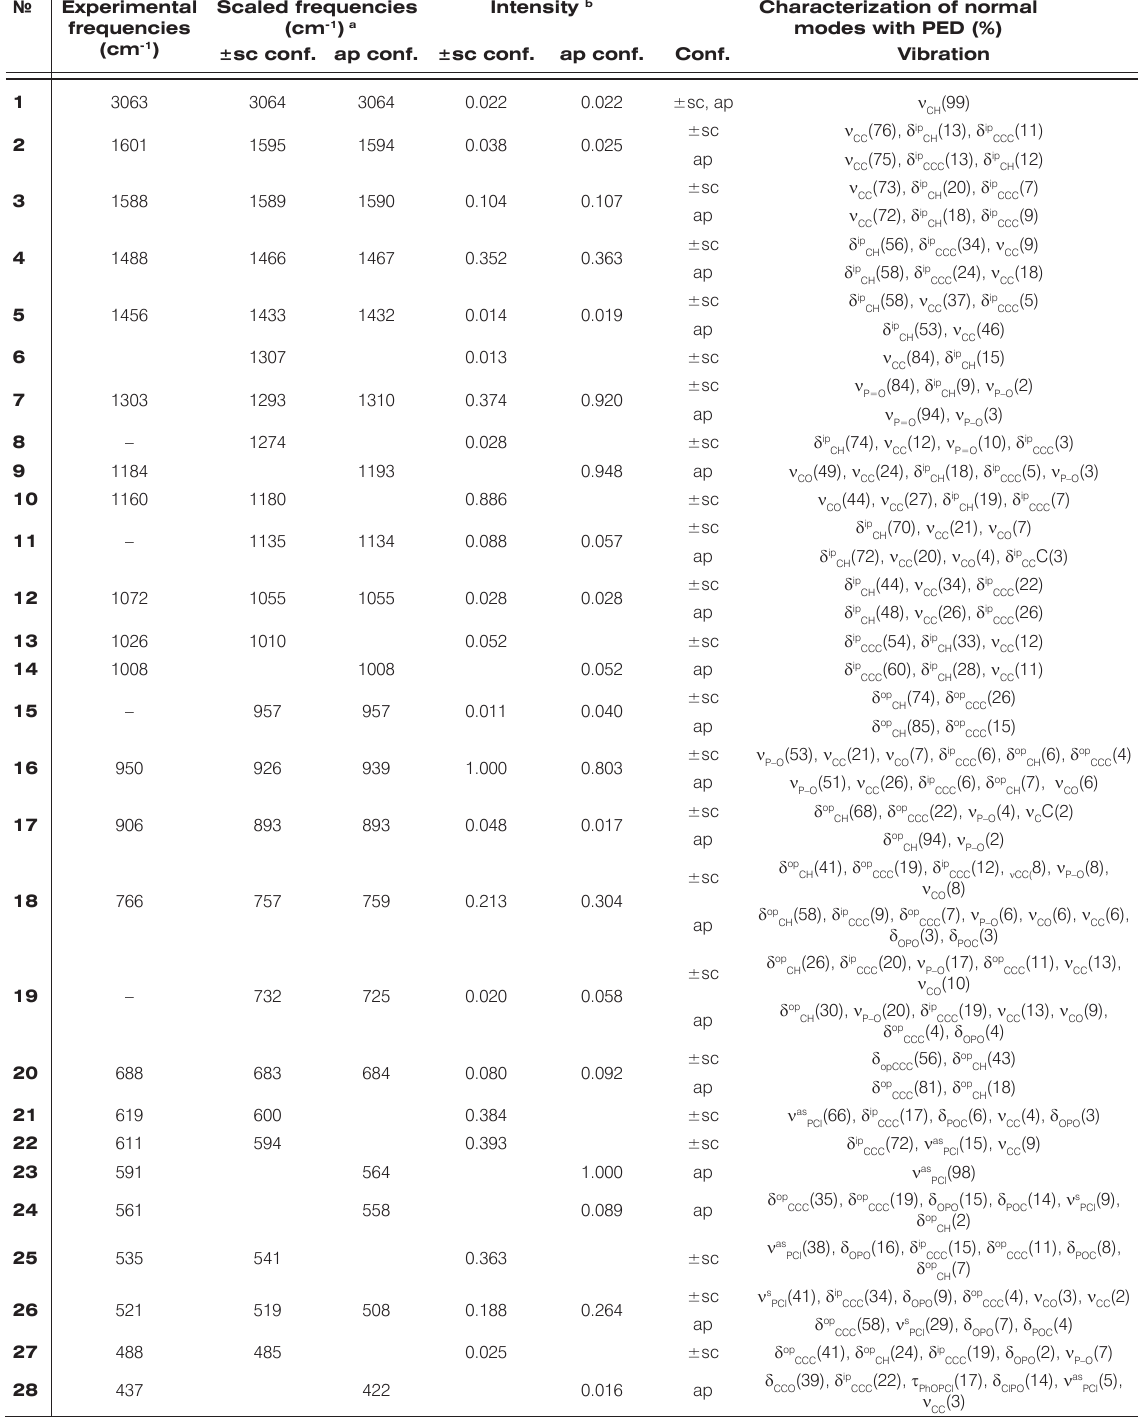
Table 3. Assignments of fundamental vibrations of phenyl dichlorophoshate. Scaled frequencies Intensity b Characterization of normal № Experimental frequencies (cm -1 ) a (cm -1 )